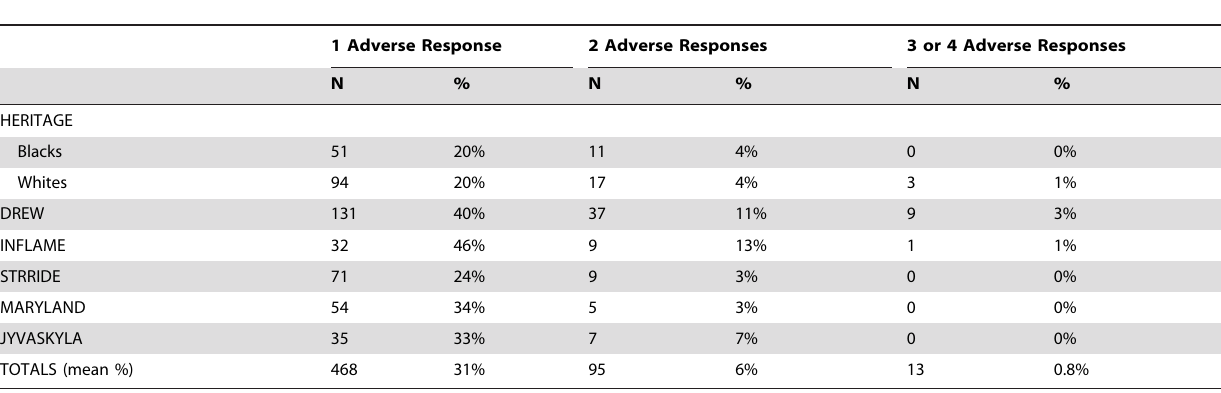
Table 8. Percentage of Subjects in Each Study with 1, 2, or 3 and More Adverse